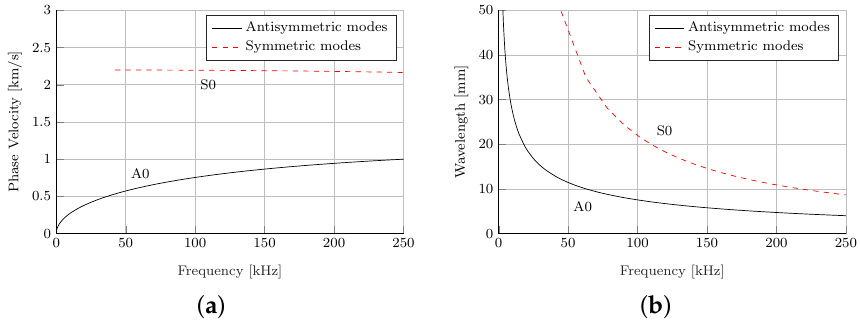
Figure 4. Dispersion diagrams of the GFRP specimen under investigation. Material properties used can be found in Table 2. ( a ) Phase velocities of the fundamental modes. ( b ) Wavelengths of the fundamental modes. Table 2. Material properties of the individual layers used in the numerical